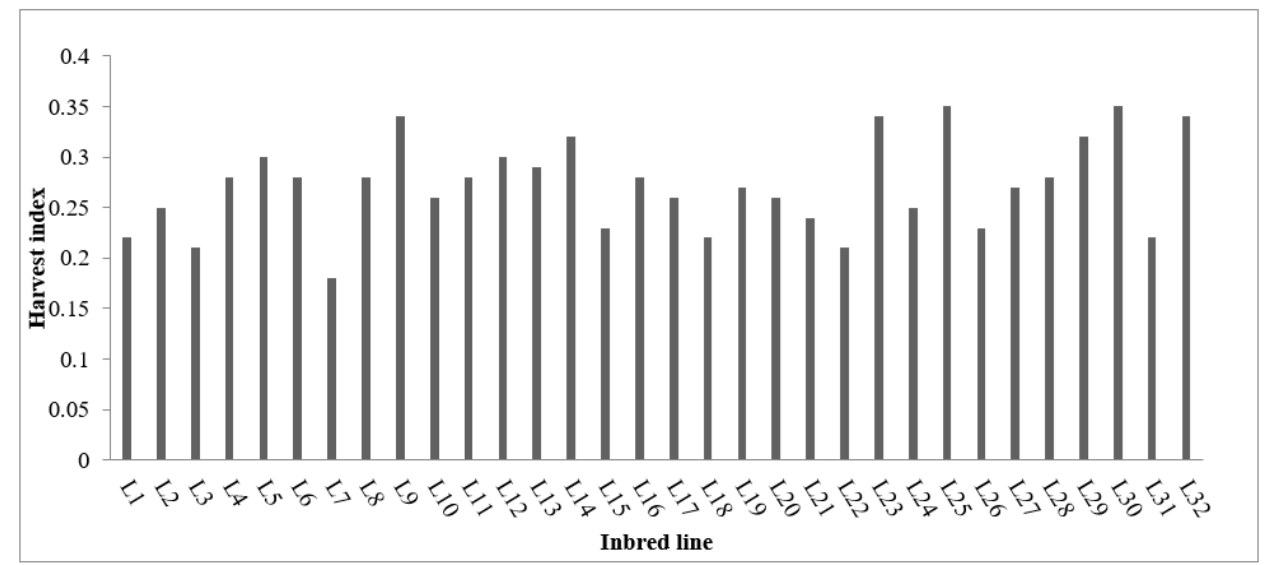
Figure 1. Harvest index of inbred lines across different levels of nitrogen application.